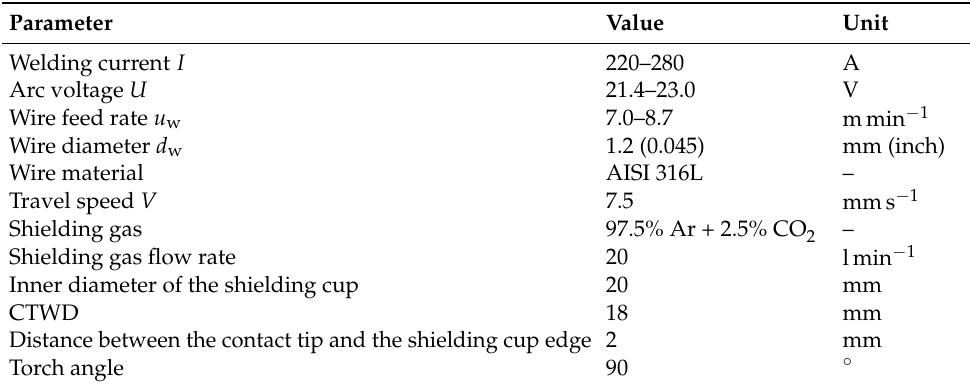
Figure 1. Schematic of gas metal arc welding and three different joint shapes studied in the present work. For the sake of clarity, only parts of the gas layer are shown. Here W r refers to the width of flat region at the base of the groove, referred to as the root-leg. Table 1. Welding parameters studied in the present